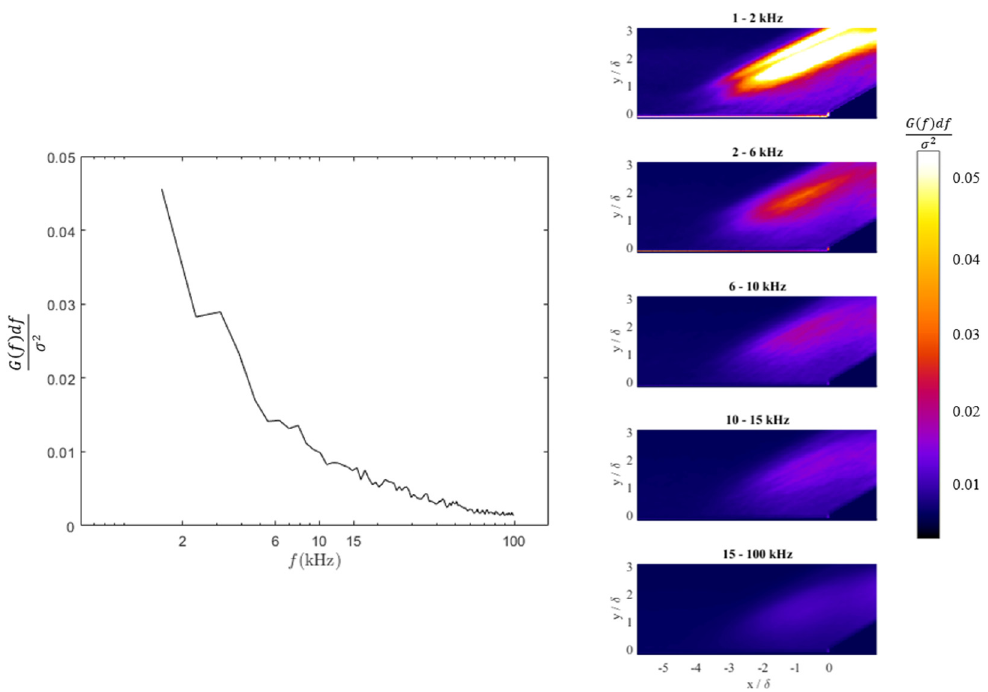
Figure 11. Normalized power spectra of high-speed schlieren images, averaged over different frequency bands for smooth surface.